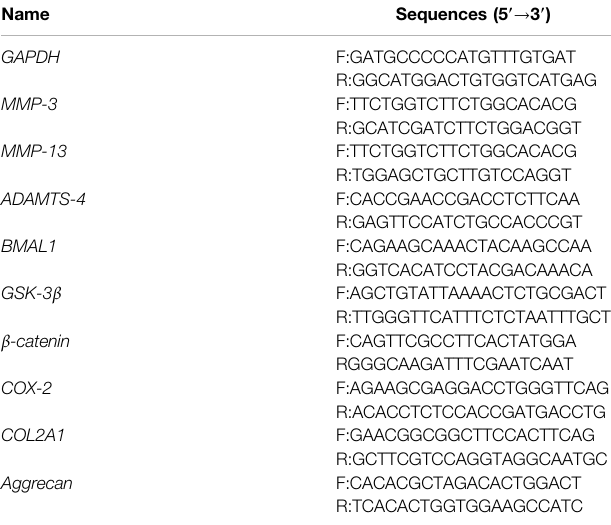
TABLE 2 | Primer sequences for the